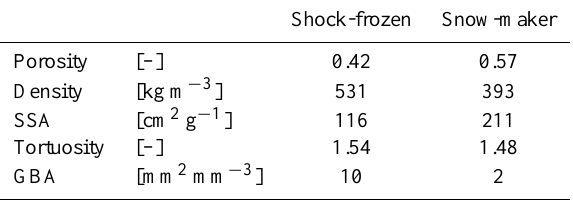
Table 2. Properties of the different types of snow samples as deter- mined by stereology (grain boundary area) and by X-ray-computed micro-tomography. SSA is the specific surface area and GBA